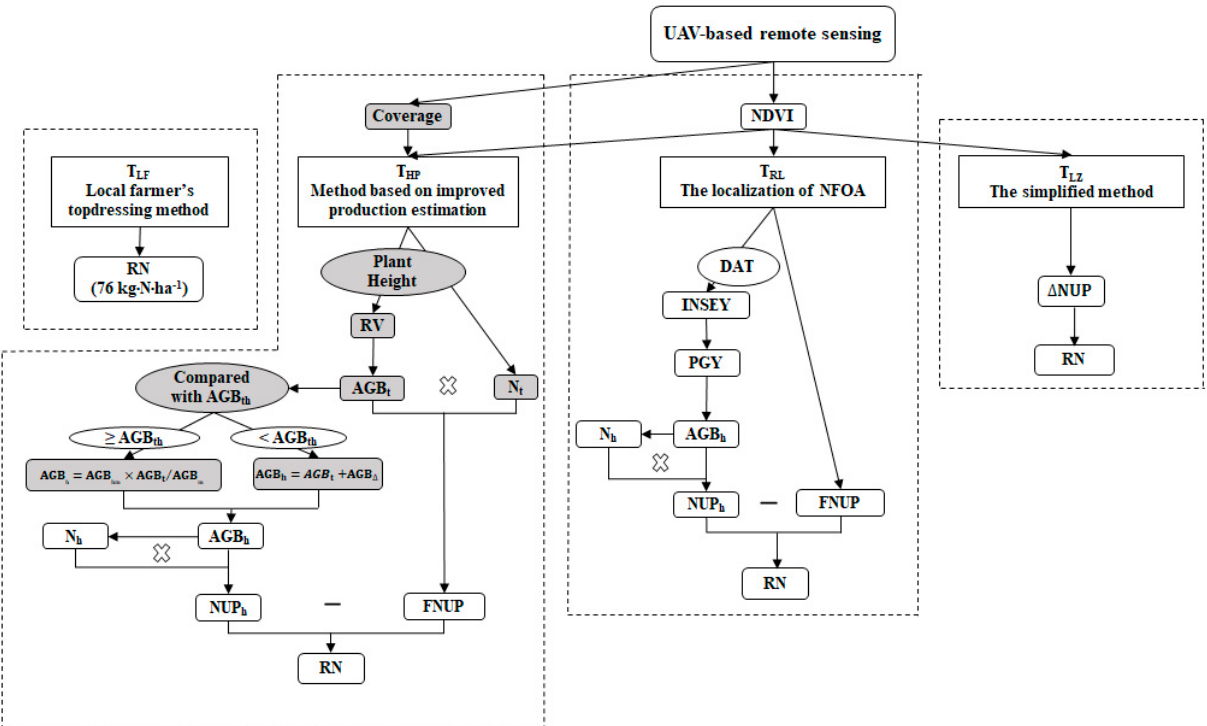
Figure 1. Calculation steps of 4 topdressing methods for winter wheat. (T HP , T RL , T LZ and T LF are different topdressing methods; RN: recommended nitrogen fertilizer amount for topdressing, RV: relative volume, AGB: above ground biomass, N t : nitrogen concentration in aboveground part at topdressing period, N h : nitrogen concentration in aboveground part at harvest, INSEY: in-season estimates of grain yield, PGY: predicted grain yield, FNUP: forage nitrogen uptake, NUP: N uptake in the aboveground part; the subscripts represent different times, i.e., t represents topdressing and h represents harvest, except for AGB th , which represents a threshold of AGB at topdressing).